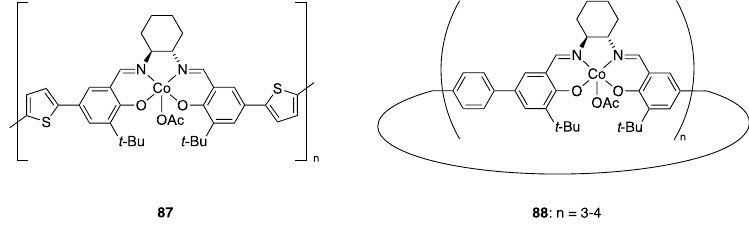
Figure 35. Polymeric Co–salen catalyst 87 and calixsalen Co catalyst 88 .